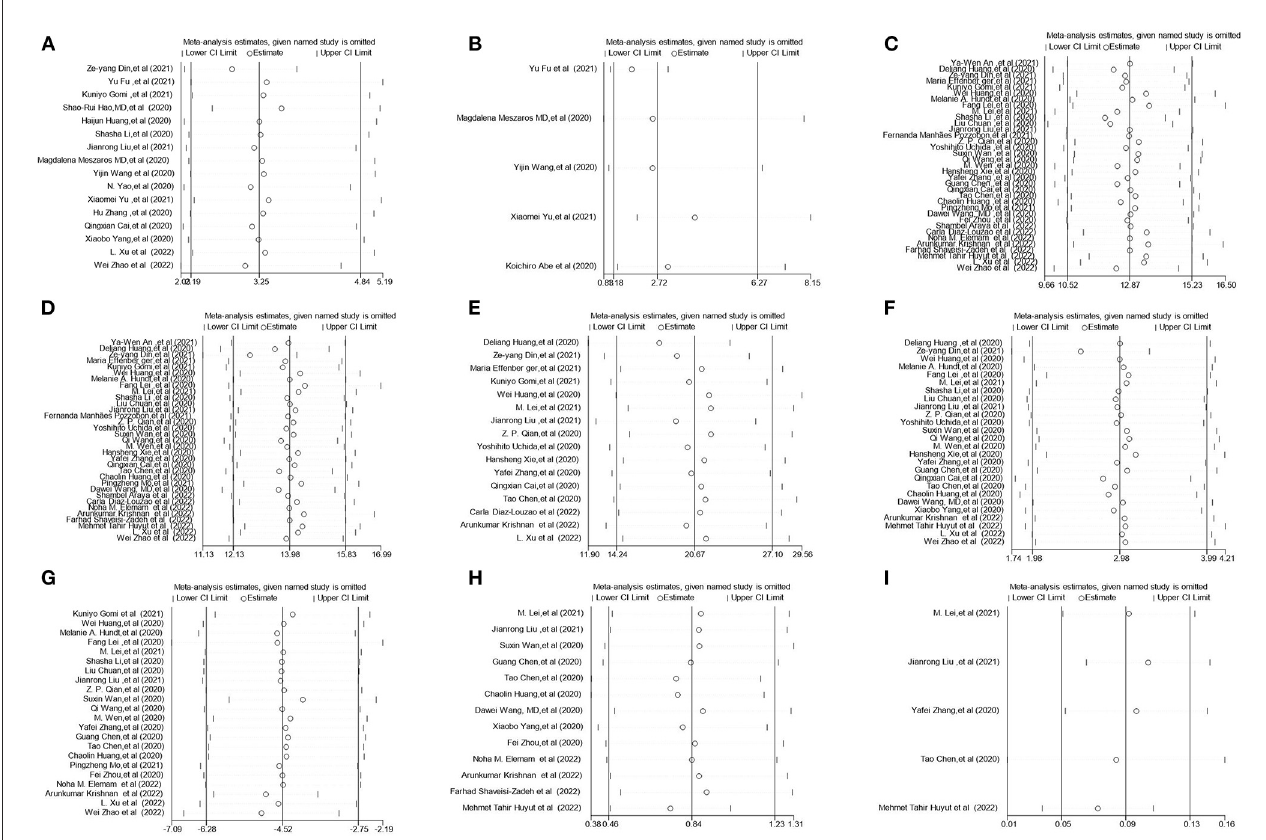
FIGURE4 Sensitivity analysis of the serum liver chemistries between severe and non-severe patients with COVID-19. (A) Prevalence of liver injury. (B) The mortality association with COVID-19 infection between liver injury and non-liver injury cases. (C) Serum ALT levels. (D) Serum AST levels. (E) Serum GGT levels. (F) Serum TBIL levels. (G) Serum ALB levels. (H) Serum PT levels. (I) INR levels. ALT, alanine aminotransferase; AST, aspartate aminotransferase; GGT, gamma-glutamyl transferase; TBIL, total bilirubin; ALB, albumin; PT, prothrombin time; INR, international normalized